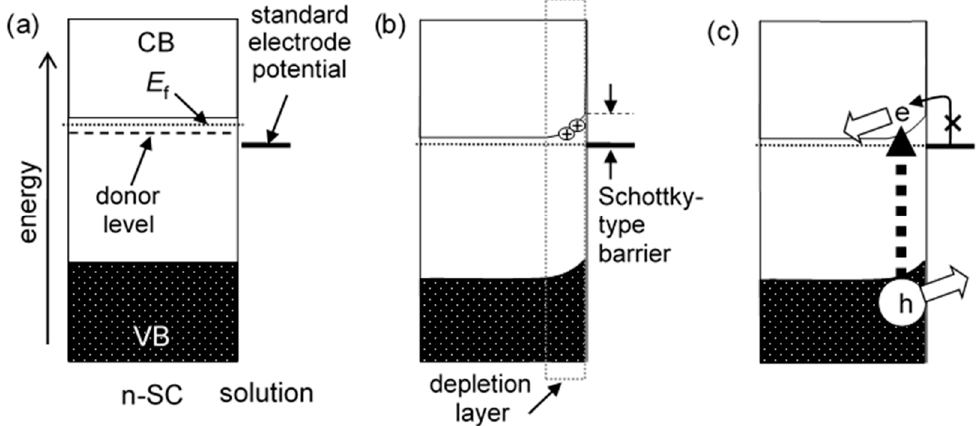
Figure 1. ( a ) N-type semiconductor (n-SC) solution. ( b ) Schottky-type junction with a depletion layer